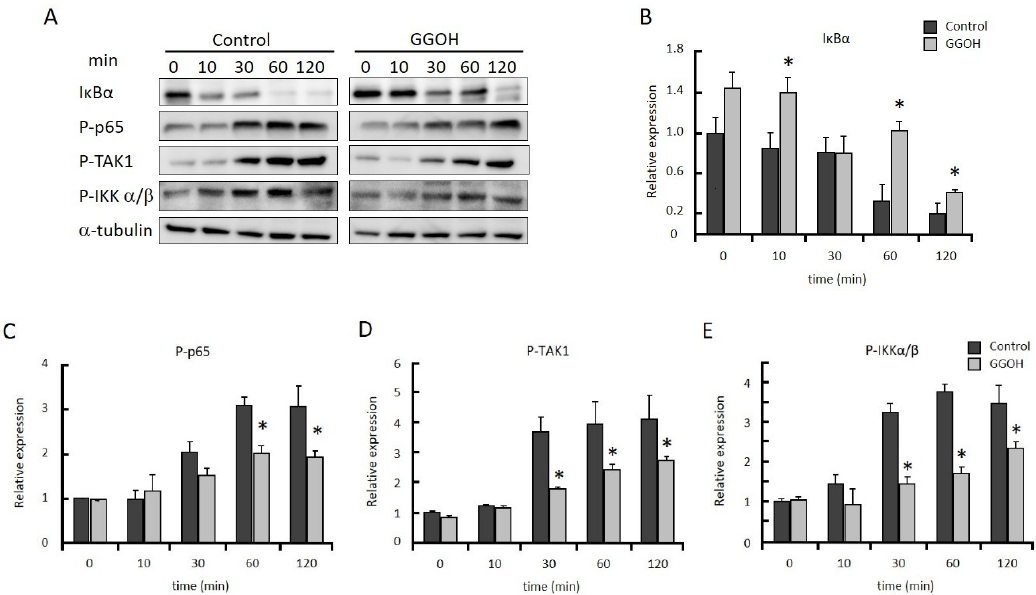
Figure 2. GGOH prevents the activation of NFκB in LPS-stimulated THP-1 cells. Differentiated THP-1 cells were preincubated with or without GGOH for 24 h before LPS stimulation. The cells were harvested after the indicated time of LPS treatment and the protein levels were measured by western blot, as described in the experimental procedures ( A ). Relative protein levels of IκBα ( B ), phosphorylated NFκB p65 ( C ), phosphorylated TAK1 ( D ), and phosphorylated IKKα/β ( E ). All values represent the mean ± SEM; n = 3. * The values are significantly different compared with the corresponding control value at p < 0.05, as assessed by Student’s t -tests.